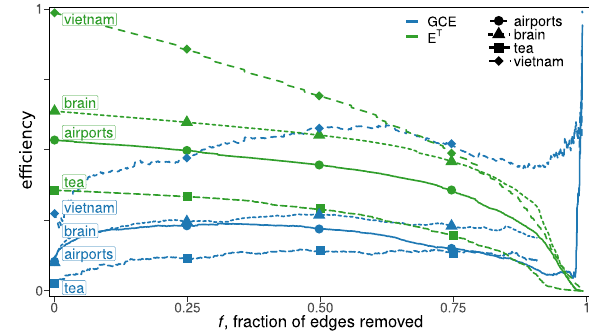
Fig. 6 Targeted bond percolation of real interconnected systems. The descriptors are the topological ef fi ciency E T and the global communication ef fi ciency GCE of real networks where edges are removed in decreasing order according to their weight. The networks are: The tea trade network, the internal migrations in Vietnam, the air traf fi c between airports in Europe and Africa, and the human brain network. See also Figs. S9 and S10 in the Supplementary Note 2.